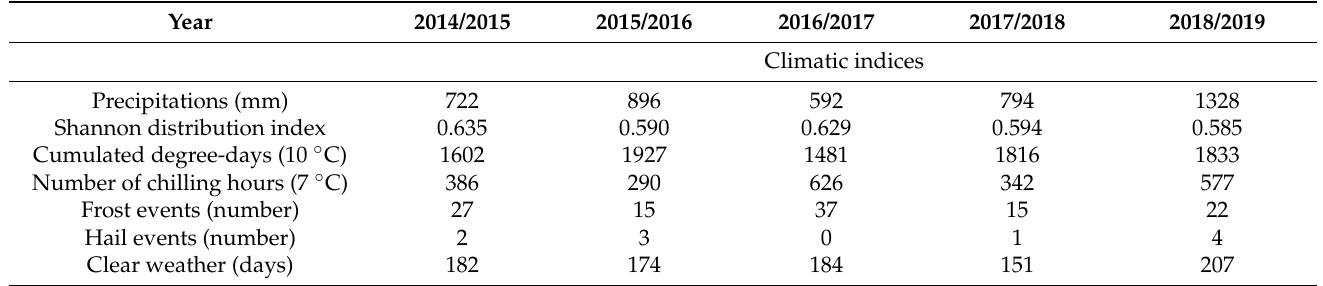
Table 1. The median values of the synthetic climatic indices and target variables during the five seasons.